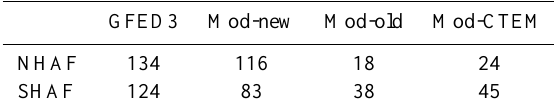
Fig. 8. 1997–2004 average (a) global annual burned area and (b) spatial dispersion of annual burned area fraction on global land surface grids quantified by coefficient of variation CV from GFED3 and CESM1 simulations with the fire parameterization introduced in Sect. 3 (Mod-new), CESM1 current fire parameterization (Mod- old) and modified CTEM-FIRE (Mod-CTEM). Table 4. Annual burned area (Mha) for Africa (NHAF: North- ern Hemisphere Africa; SHAF: Southern Hemisphere Africa) from GFED3 and CESM1 simulations with the fire parameterization in- troduced in Sect. 3 (Mod-new), CESM1 current fire parameteriza- tion (Mod-old) and modified CTEM-FIRE